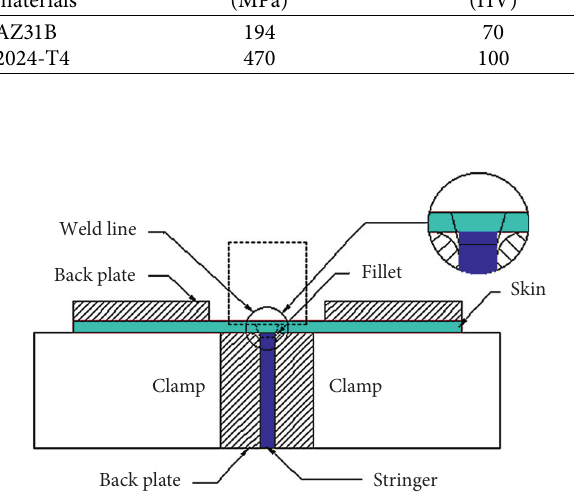
Figure 1: Schematic diagram of the friction stir welding process of